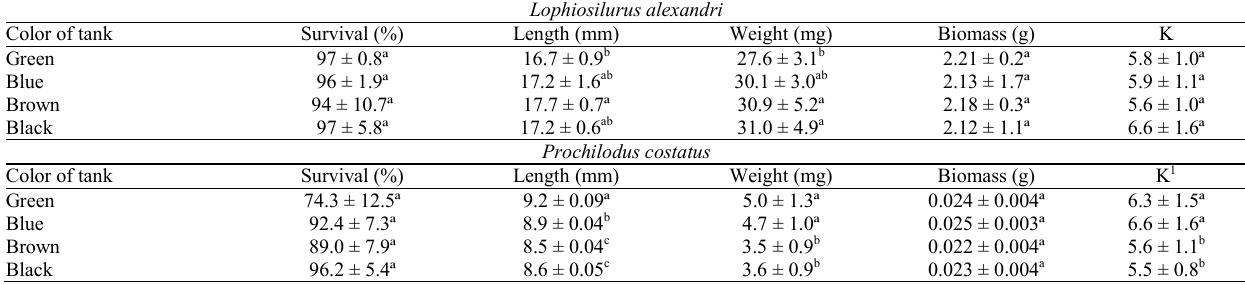
Table 3. Average values (± standard deviation) of the larvae of pacamã ( Lophiosilurus alexandri ) and curimatá-pioa ( Prochilodus costatus ) cultivated in tanks of four different colors, for 10 days. K = Fulton’s condition factor. Averages in the same column followed by different letters differed significantly (P<0.05) by Tukey’s test.